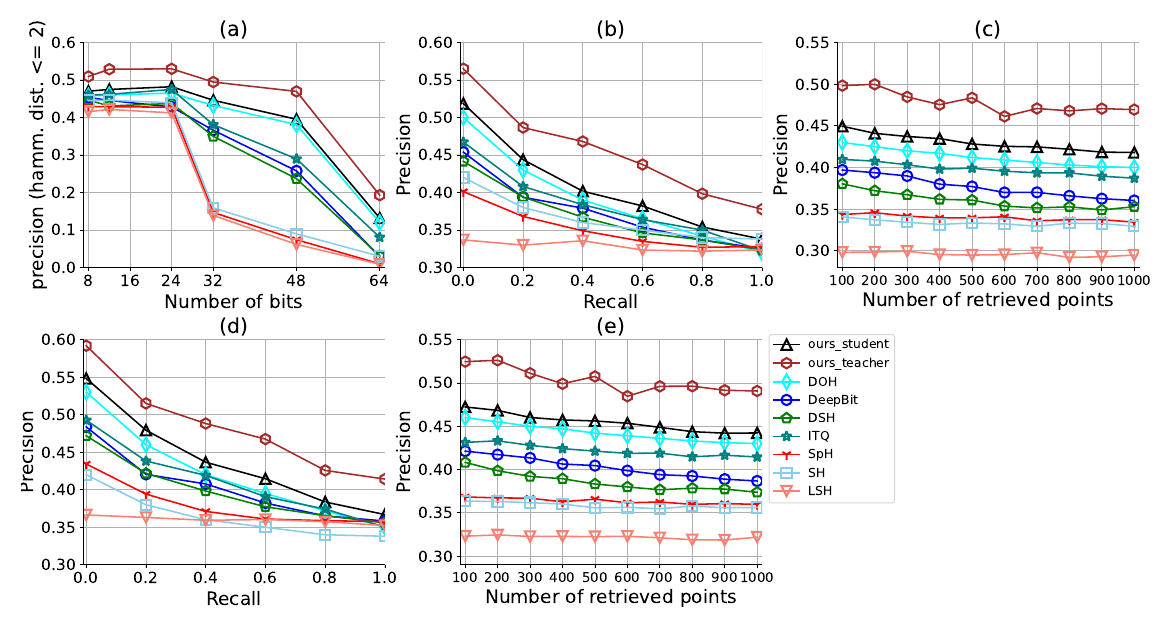
Figure 4. Performance curves of retrieval results on the NUS-WIDE dataset: ( a ) Precision using hash lookup within Hamming radius 2; ( b ) Precision–recall curve for 48 bits; ( c ) Precision curve for 48 bits; ( d ) Precision–recall curve for 24 bits; and ( e ) Precision curve for 24